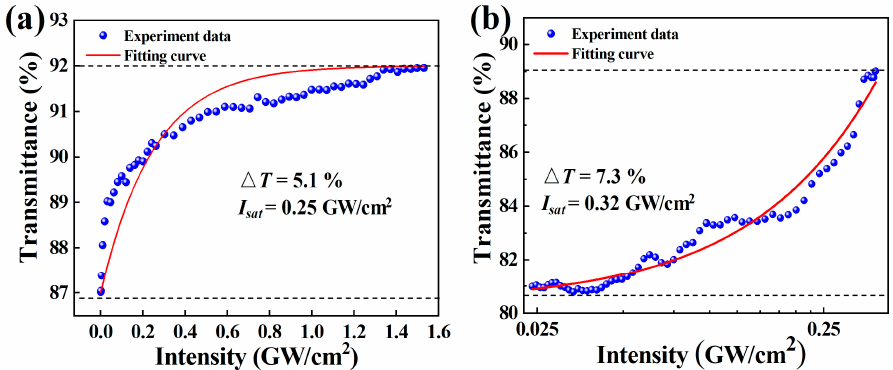
Figure 3. ( a ) Corresponding nonlinear saturable absorption curve in 1.5 μ m. ( b ) Corresponding non- linear saturable absorption curve in 1 μ m.